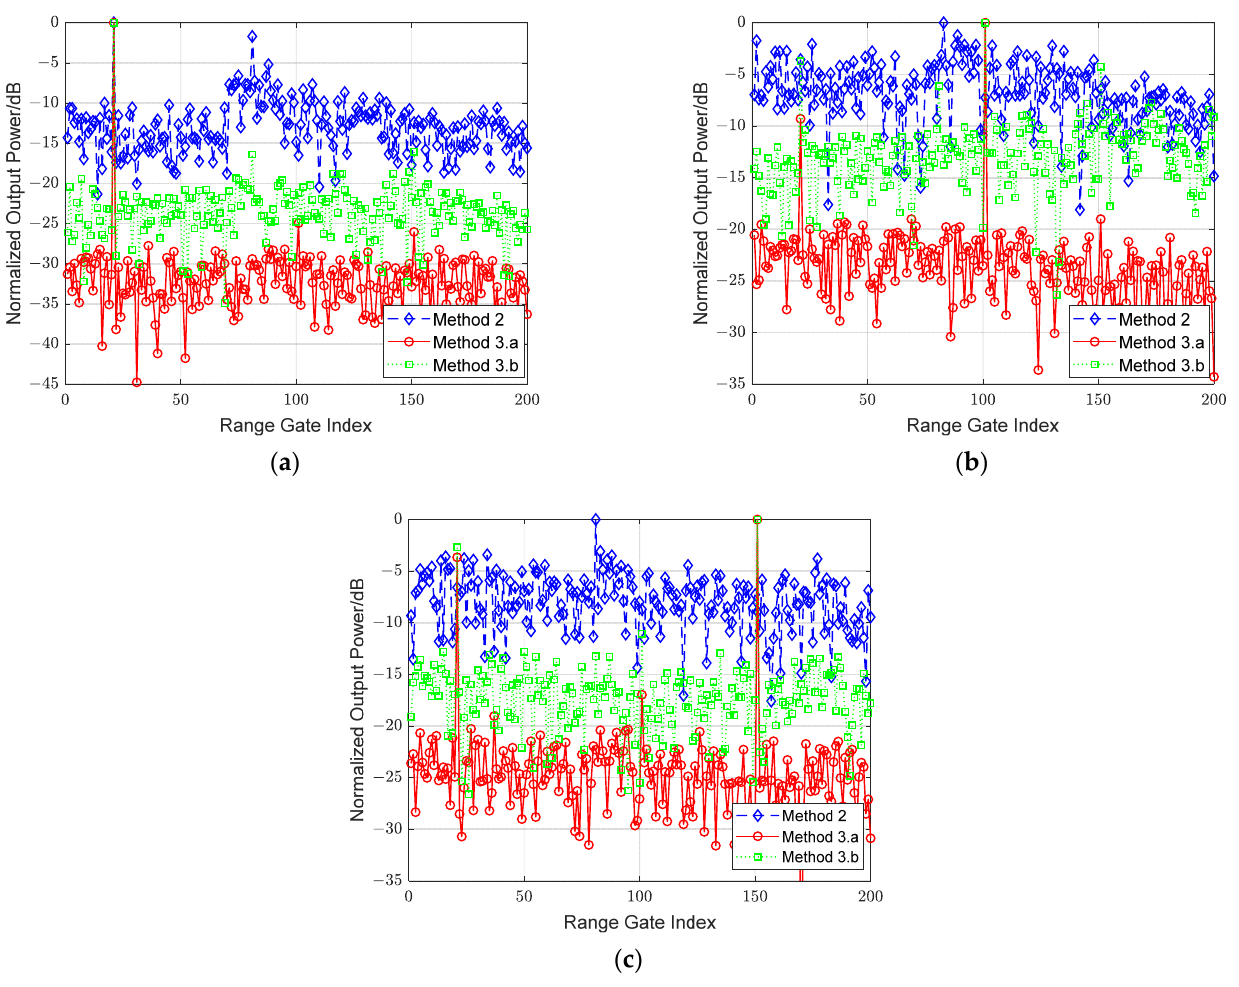
Figure 12. Normalized output power spectrum in different Doppler channels by method 2, 3.a and 3.b: ( a ) Doppler channel of 1st target; ( b ) Doppler channel of 2nd target; ( c ) Doppler channel of 3rd target.